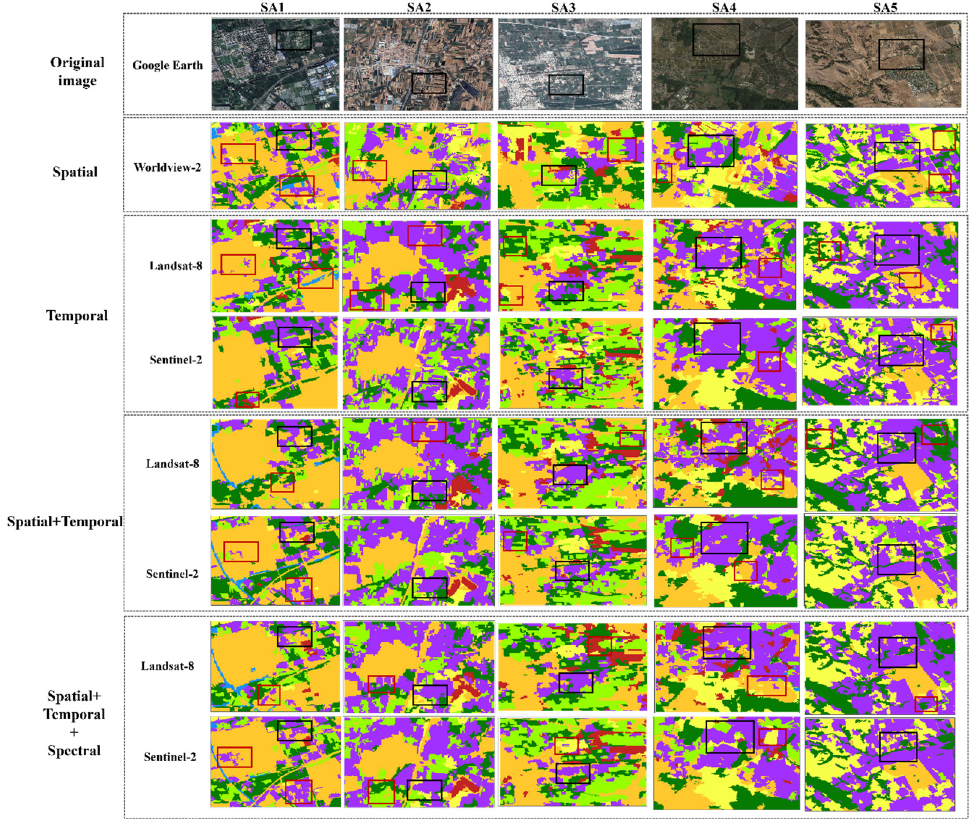
Figure 14. Comparison between different feature classification maps and Google Earth high-resolution images, where the black box is an example of correct classification, and the red box is an example of incorrect classification.